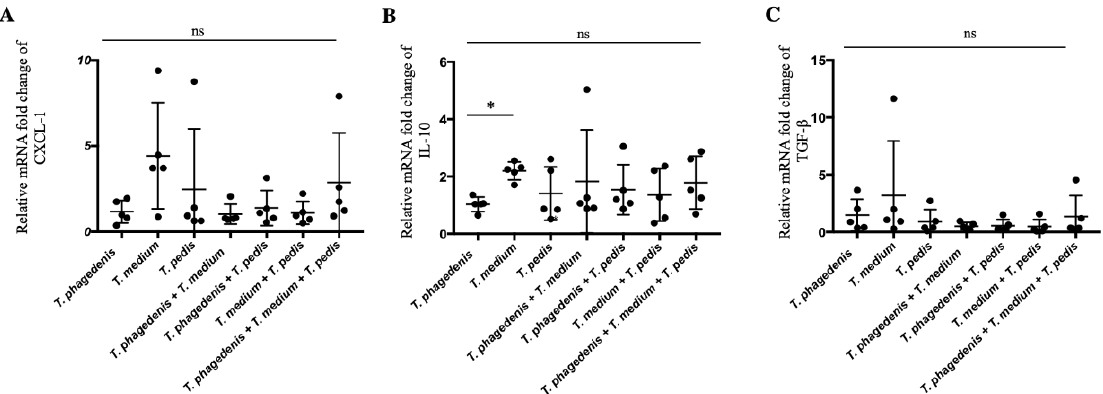
Figure 5. Transcriptional gene expression of Cxcl-1 ( A ), IL-10 ( B ) and TGF- β ( C ) abscess lesions of mice challenged by Treponema single and multiple combination of species. Means and standard deviation are presented. Analyzed by ANOVA using Tukey’s post hoc test. * p < 0.05.